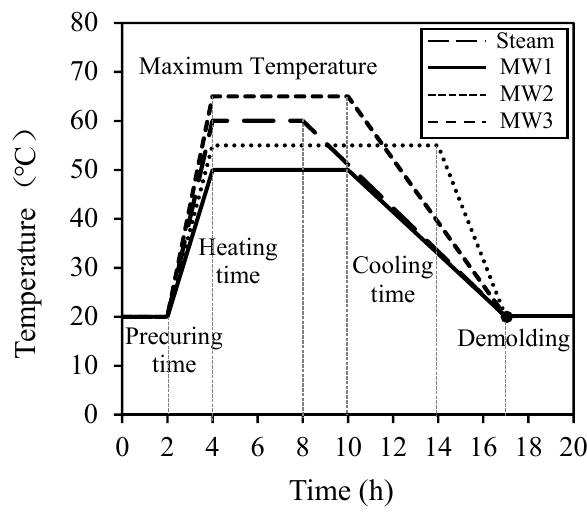
Figure 3. Curing cycle.